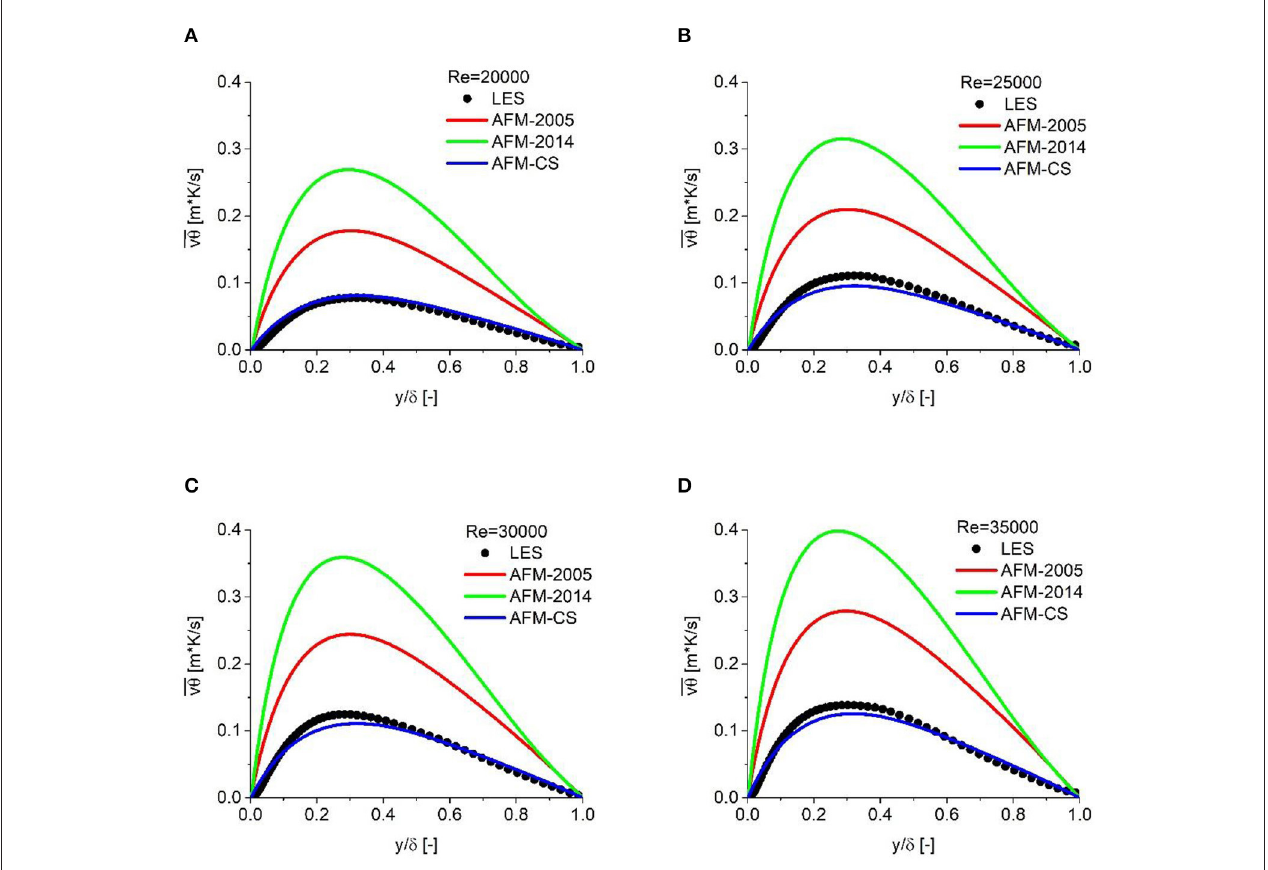
FIGURE 8 | Turbulent heat flux in the wall-normal direction for different Reynolds numbers. (A) Re = 20000, (B) Re = 25000, (C) Re = 30000, and (D) Re =